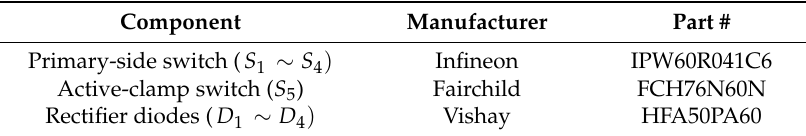
Table 5. Components used in the prototype